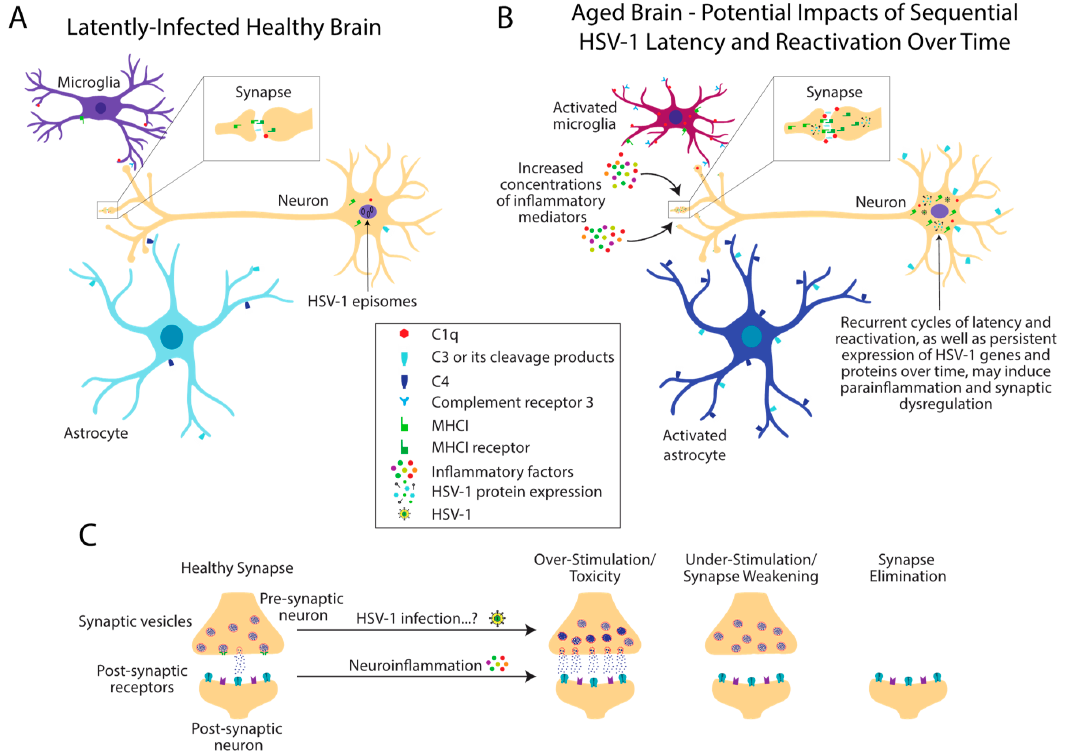
Figure 3. Recurrent cycles of HSV-1 latency and reactivation may cause aberrant neuroinflammatory responses and synaptic dysfunction with advanced age. ( A ) If HSV-1 enters the central nervous system (CNS), latency will be established in the nucleus of infected neurons. Neuronal and glial expression of immune factors including members of the complement pathway and the MHCI processing and presentation pathway are expressed at homeostatic levels. ( B ) Local immune responses triggered by the expression of lytic viral genes, combined with multiple cycles of HSV-1 reactivation from latency, may over time lead to the deleterious expression of immune proteins. Aberrant expression of these proteins may cause the activation of microglia and astrocytes, as well as the dysregulation of neuron-neuron and / or neuron-glial communication. ( C ) Altered expression of immune factors at neuronal synapses may lead to neuronal over-stimulation and toxicity, under-stimulation and synaptic weakening, and / or synaptic pruning initiated by microglia. Diagram: figure adapted from [136], cell type illustrations from BioRender.com.